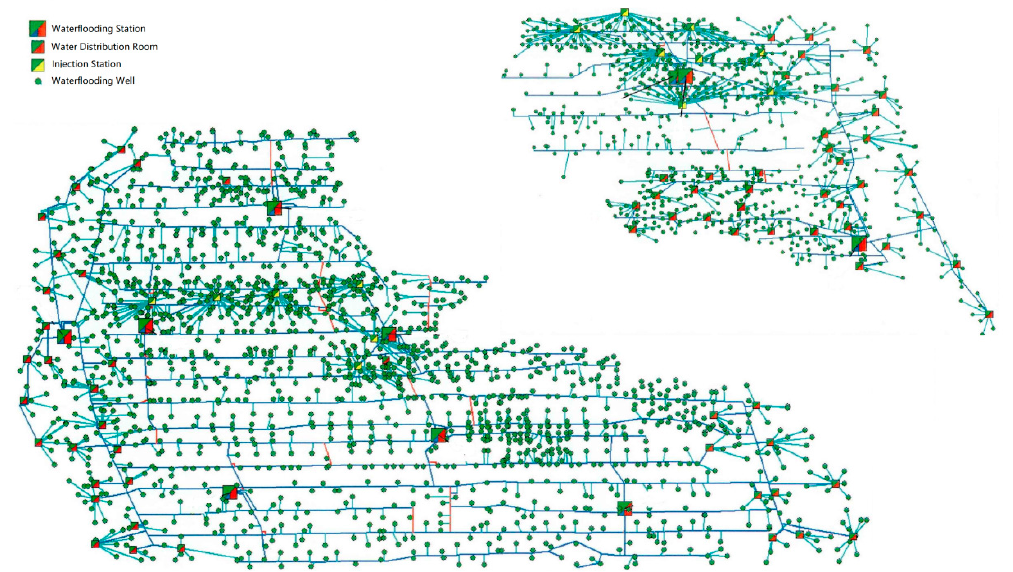
Figure 10. Different pressure diagram of the system.